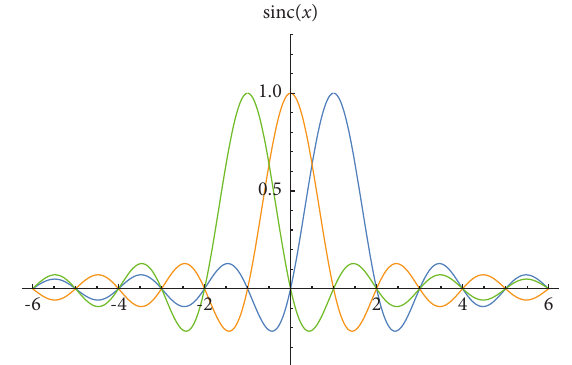
Figure 1: The kth sinc function S ( k, h )( x ) , k � ∓ 1 and k � 0, while stepsize h is